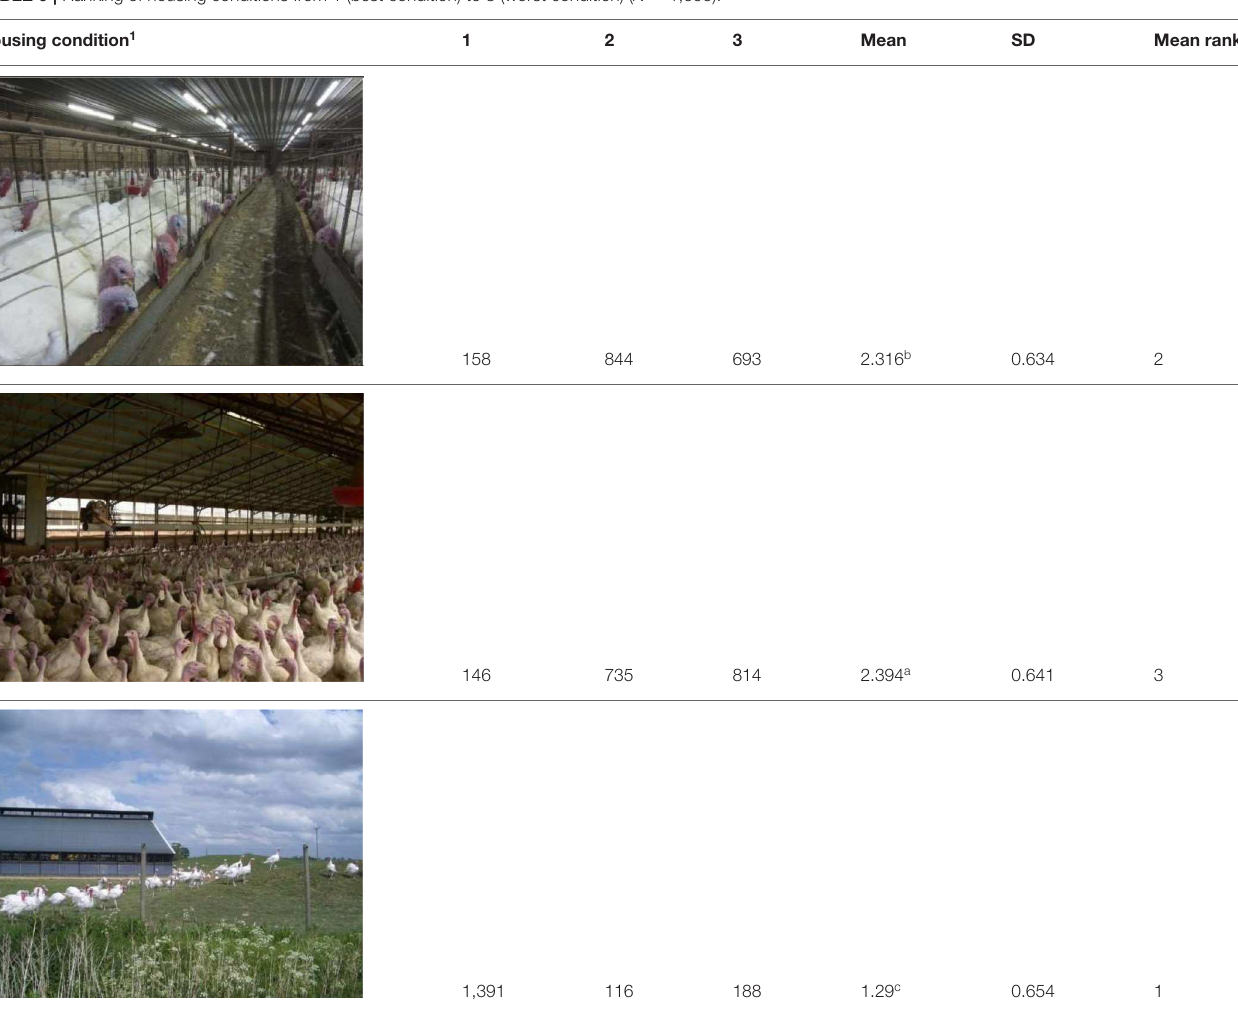
TABLE 6 | Ranking of housing conditions from 1 (best condition) to 3 (worst condition) ( N = 1,695). Housing condition